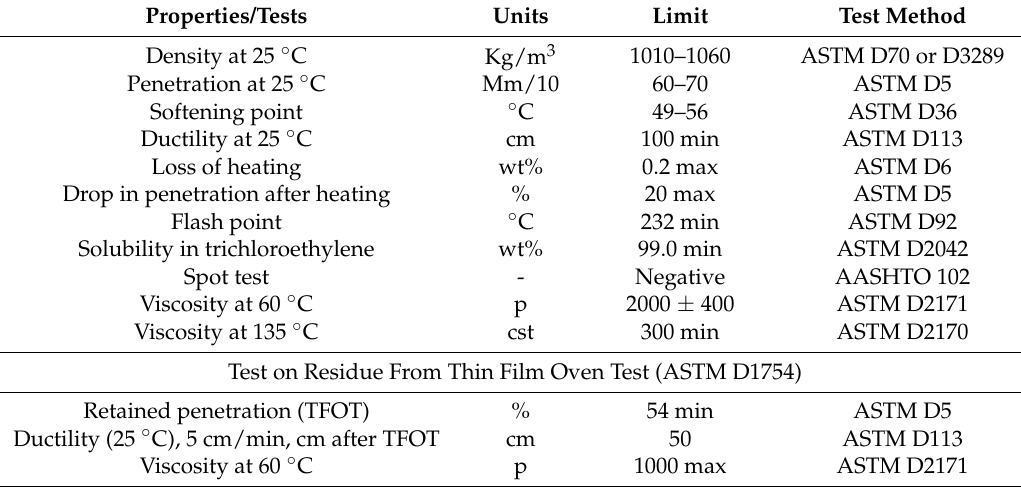
Table 1. Standards for testing bitumen properties.